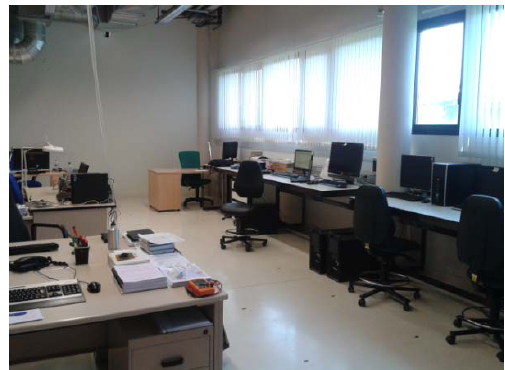
Figure 5. Image of R&D Communications Center laboratory N° 2, in which